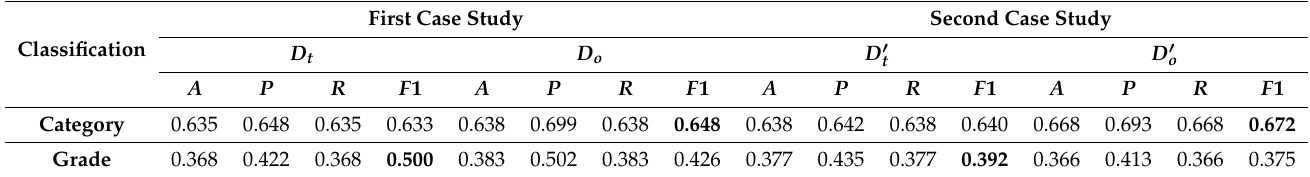
Table 8. Results obtained using the LDA